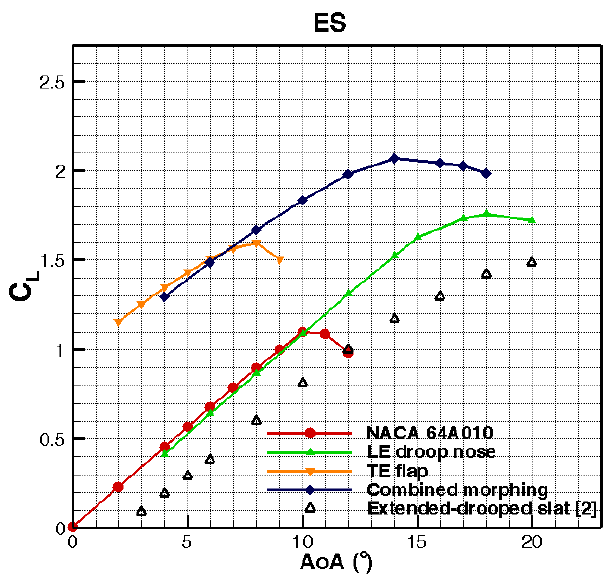
Figure 10. Effects of the individual LE droop nose and TE flap morphing and their combination on the lift coefficient polar. PSO algorithm with four generations (560 evaluations) was employed for the individual as well as the combined morphing optimization. Flow simulations were performed using Foil2w. Measurements for extended and drooped slat are reported in [28].